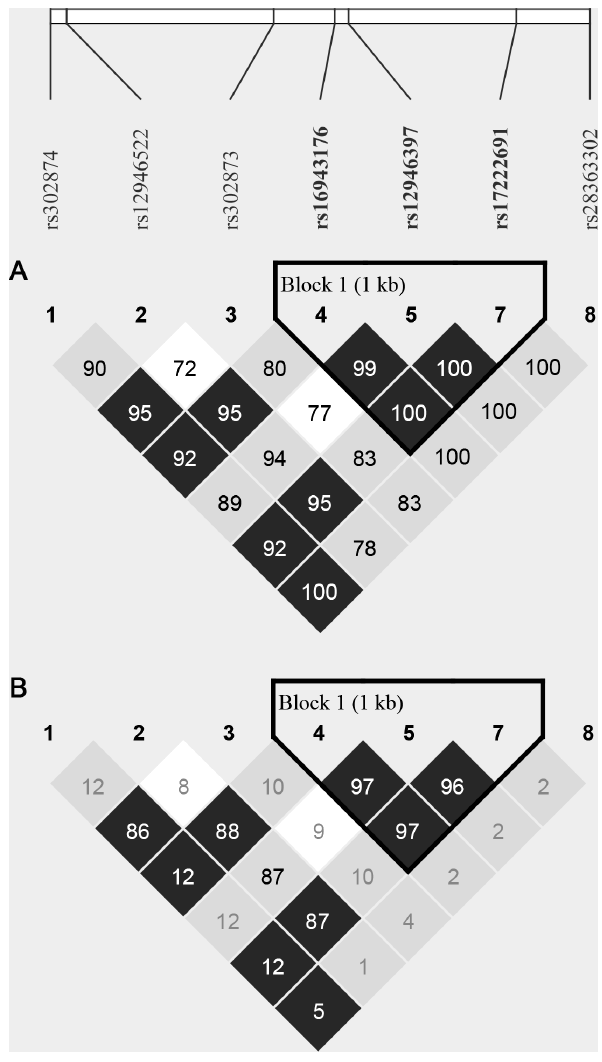
Figure 1. The map of LD between seven analyzed SNPs in non- coding regions of RAD51C . The values in the map are the normalized measures of allelic association |D’| ( A ) and correlation coefficients (r 2 ) ( B ) calculated for each pair of SNPs (both provided as percentages). The color scheme represent the corresponding confidence bounds for a given pair of SNPs: black – strong evidence of LD; grey – inconclusive; white – strong evidence of recombination [37]. Solid line indicates the identified 1 kb-long LD block, within which common and rare haplotypes were reconstructed, the frequency of which is provided in the Table 3. Algorithm employed for LD block identification is described in the Material and Methods section. doi:10.1371/journal.pone.0110696.g001 main effects of the 7 RAD51C SNPs on DNA strand breakage were not found to be statistically significant (Table 5B).